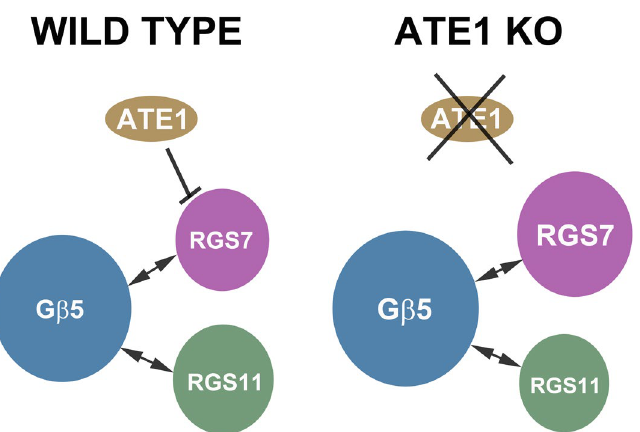
Figure 9. An interaction model illustrates how RGS7 degradation is Ate1-dependent and Ate1 knockout increases the level of RGS7. Since RGS7 competes with RGS11 (or other R7 RGS proteins) for binding with G β 5 (or other R7 binding proteins) and increases the stability of G β 5 through dimer formation, an increase in RGS7 can cause a decrease in RGS11 and/or an increase in G β 5